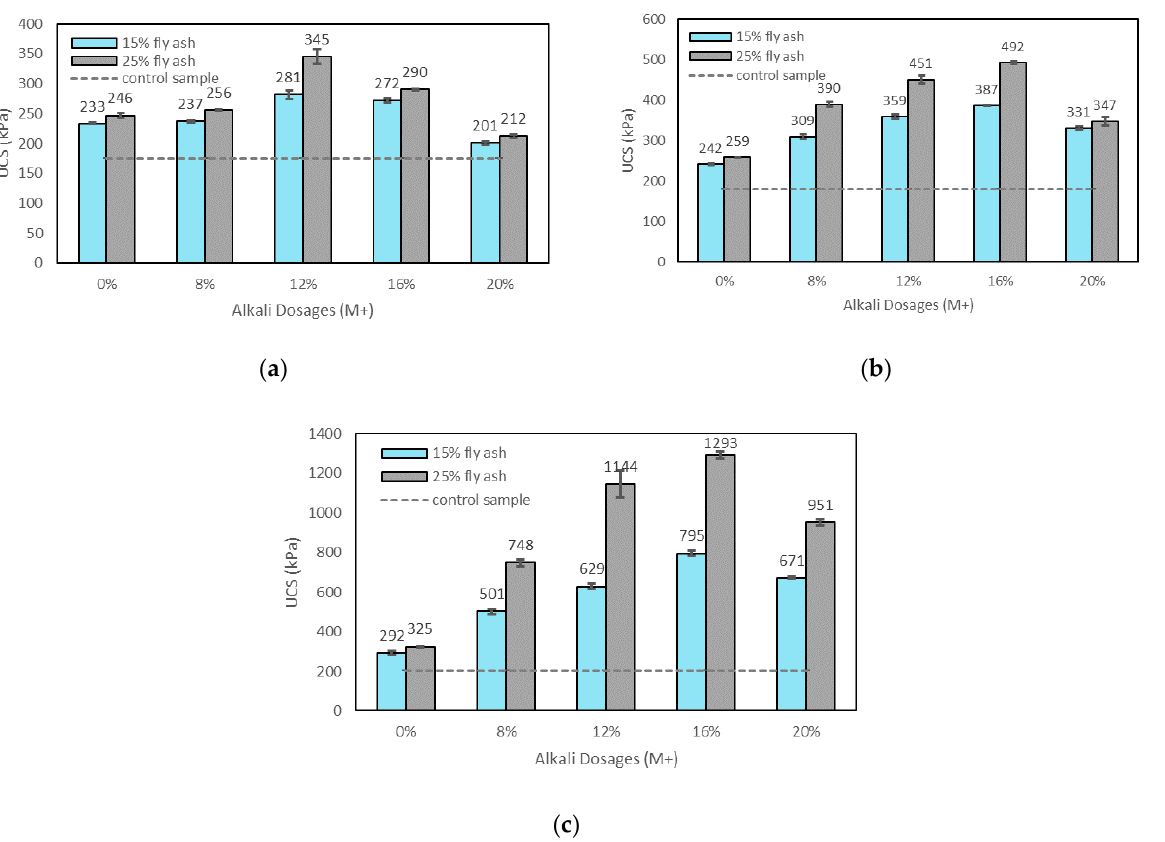
Figure 5. Effects of alkali dosages on the UCS of control sample, soils stabilised with fly ash, and soils stabilised with alkali-activated fly ash with an SM of 1.25 at ( a ) 1 day of curing; ( b ) 7 days of curing; ( c ) 28 days of curing.